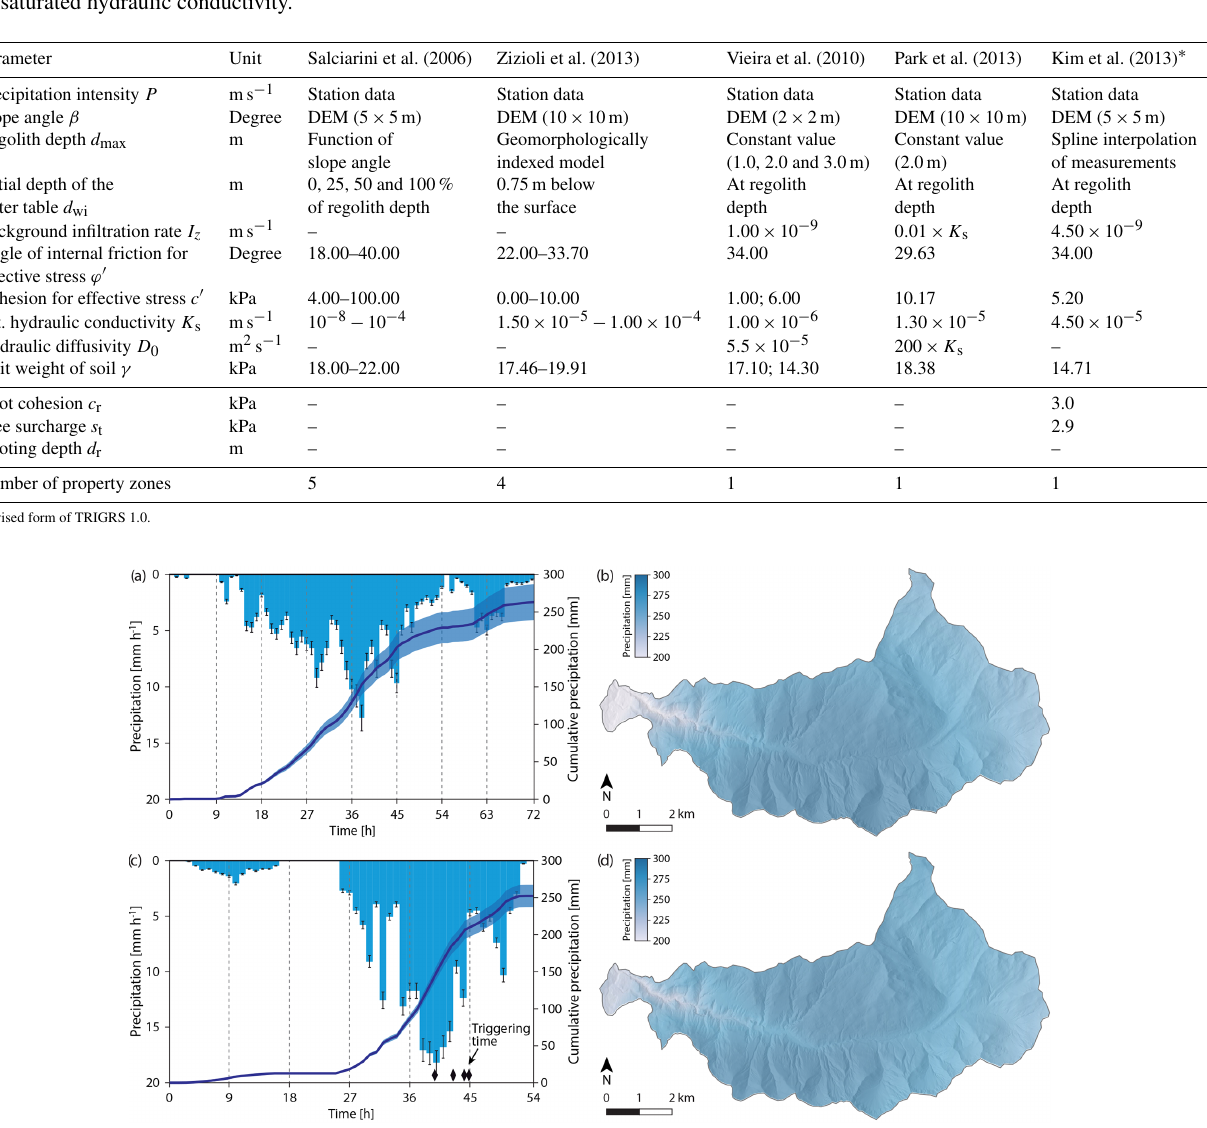
Table 2. Parameters for the revised TRIGRS 2.0 model and parameter values considered in previous studies. DEM: digital elevation model; K s : saturated hydraulic conductivity.